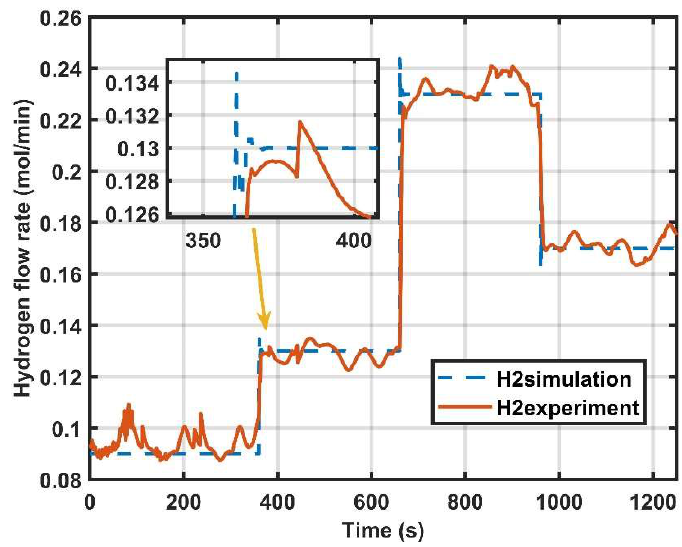
Figure 8. Schematic diagram of the simulation and experiment hydrogen flow rate.